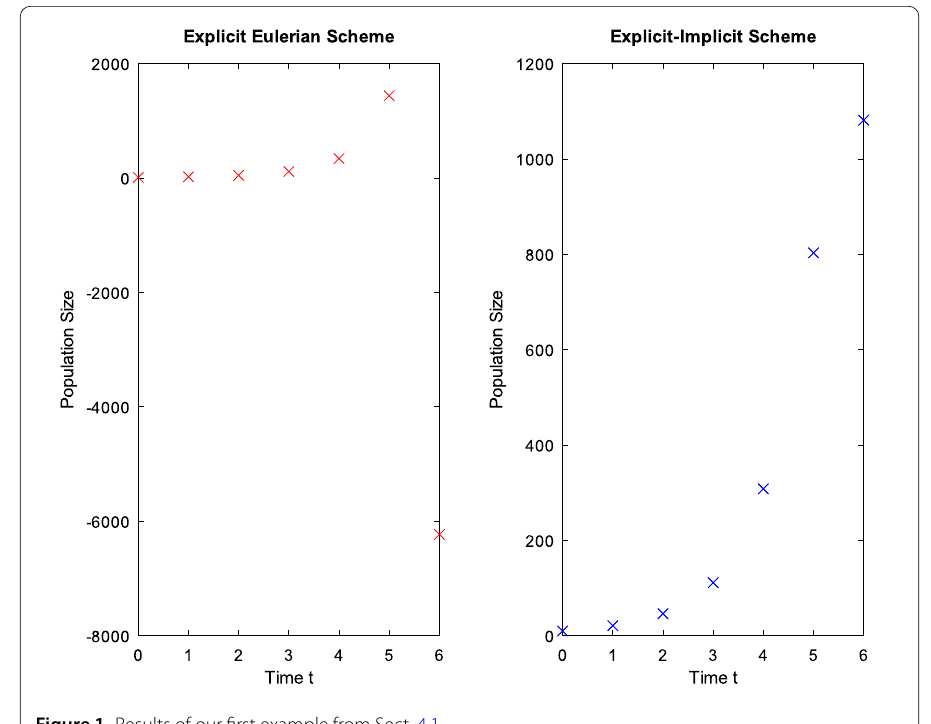
Figure 1 Results of our first example from Sect.